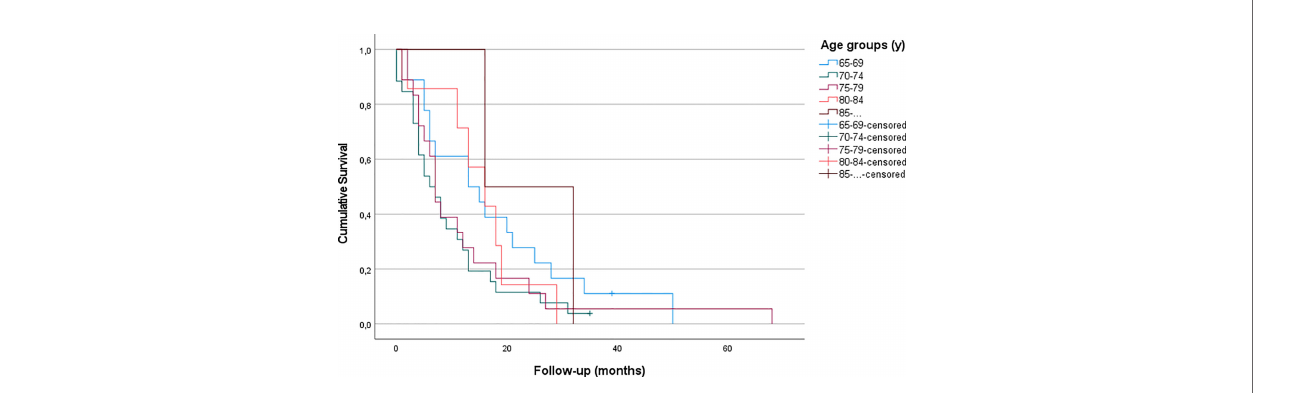
FIGURE 4 | Kaplan-Meier curves for patients of all age groups who were treated with STR (no patients under 70 and over 84 years received STR in our cohort) (p - ns).